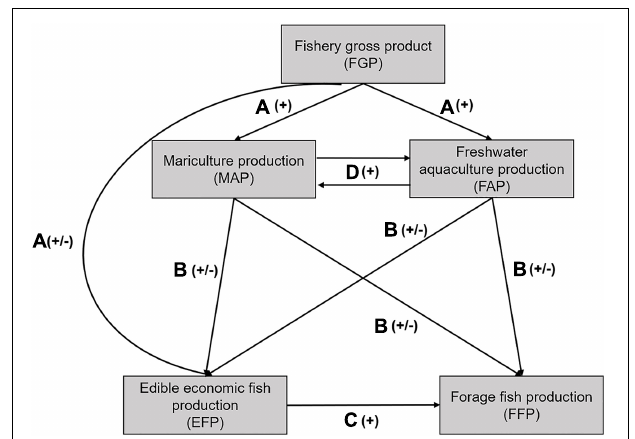
FIGURE 1 | Conceptual diagram or metamodel of hypothesized influences on marine wild fisheries. Solid black arrows depict known causal effects among variates. Arrow labels correspond to exemplar references (A) De Silva and Turchini (2009) and Zhao et al. (2018), (B) Cao et al. (2015), Chiu et al. (2013), De Silva and Turchini (2009); Han et al. (2018), Li et al. (2011), Funge-Smith et al. (2005) and Szuwalski et al. (2017), (C) Szuwalski et al. (2017), and Zhang et al. (2020), (D) Li et al. (2011) and Funge-Smith et al. (2005). Parenthetic signs next to black arrow labels indicate that the relationship is expected to be positive (+), negative (–), or variable ( ±